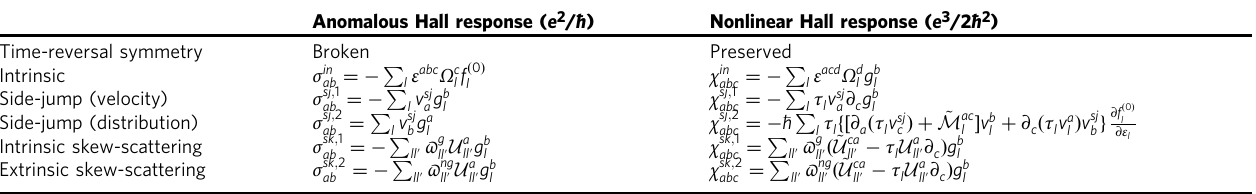
Table 1 Formulas of the anomalous and nonlinear Hall responses in the ωτ (cid:1) 1 limit Anomalous Hall response ( e 2 / ħ ) Nonlinear Hall response ( e 3 /2 ħ 2 ) Time-reversal